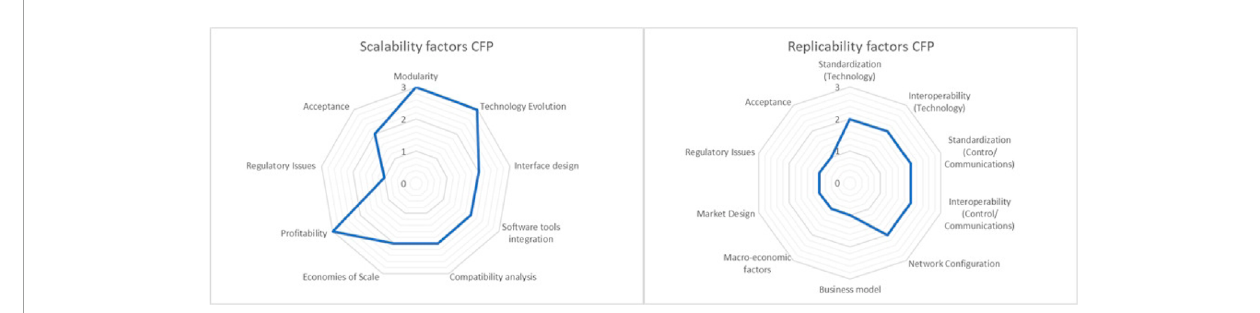
FIGURE 9 Spider graph on CFP scalability and replicability assessments.